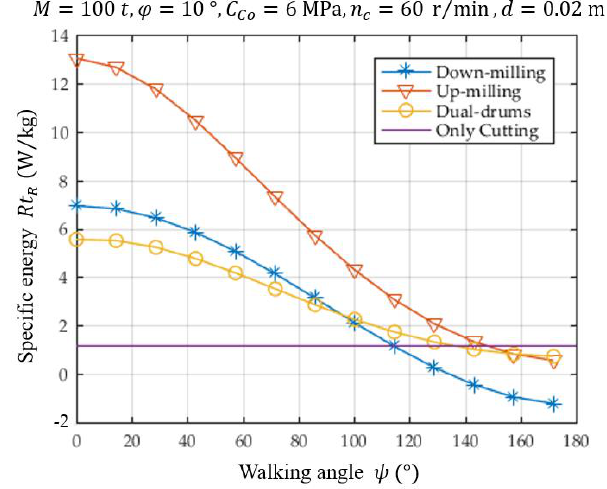
Figure 13. The specific energy of the three types of mining vehicles.